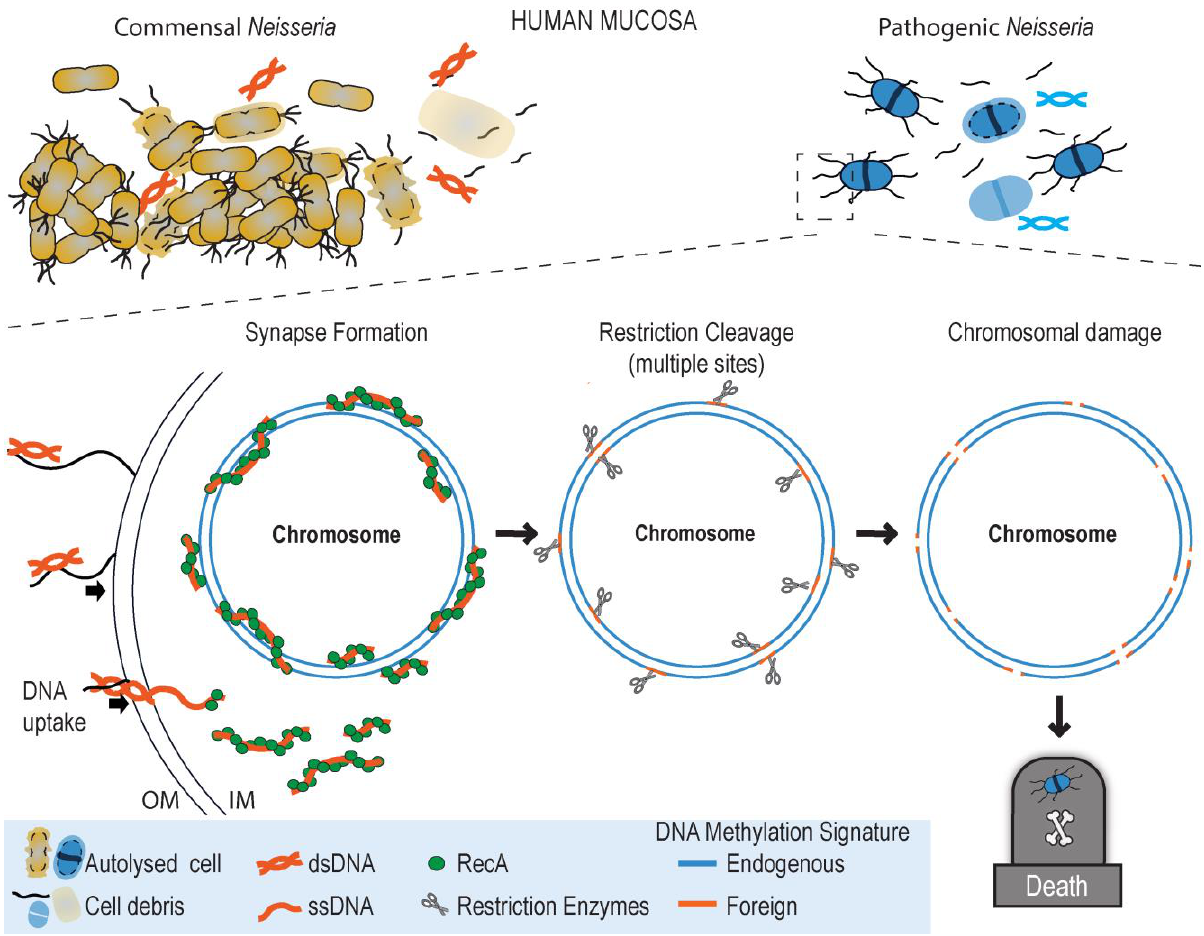
FIGURE 1: Working model for how commensal Neisseria DNA kills Neisseria gonorrhoeae on the human mucosa (see text for details). Top left: commensal Neisseria cells on a mucosal passage. Top right: Neisseria gonorrhoeae arriving in the vicinity of the commensal bio- film. Middle: cutaway showing commensal DNA entering a Neisseria gonorrhoeae cell, RecA-mediated recombination of this DNA with the pathogen chromosome, restriction enzyme cleavage of the synaptic joint, and loss of chromosome integrity and cell death. Keys to the figures are in the bottom